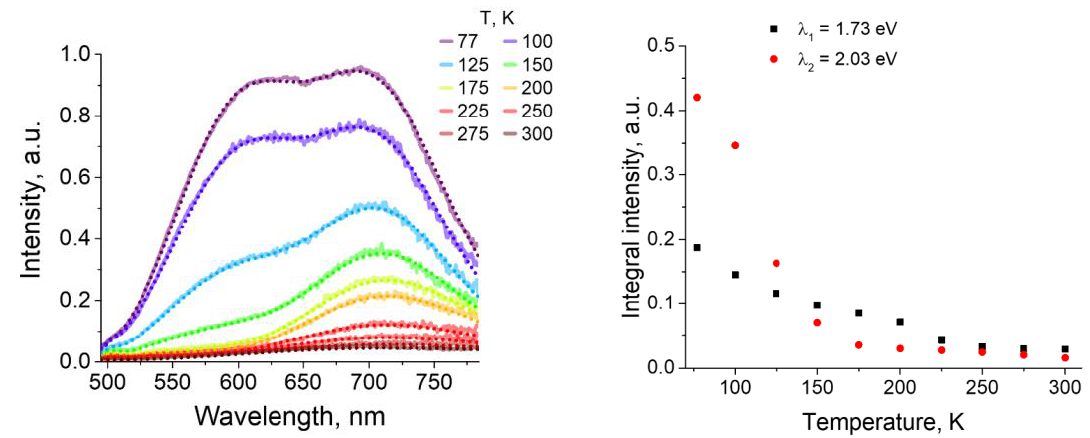
Figure 9. Temperature dependence of the PL spectra ( λ Ex = 400 nm) of 2 with two Gauss approxima- tion ( λ 1 = 1.73 eV, λ 2 = 2.03 eV) ( left ); temperature dependence of the PL bands integral intensities ( λ Ex = 400 nm) of 2 using two Gauss approximation ( λ 1 = 1.73 eV, λ 2 = 2.03 eV) ( right